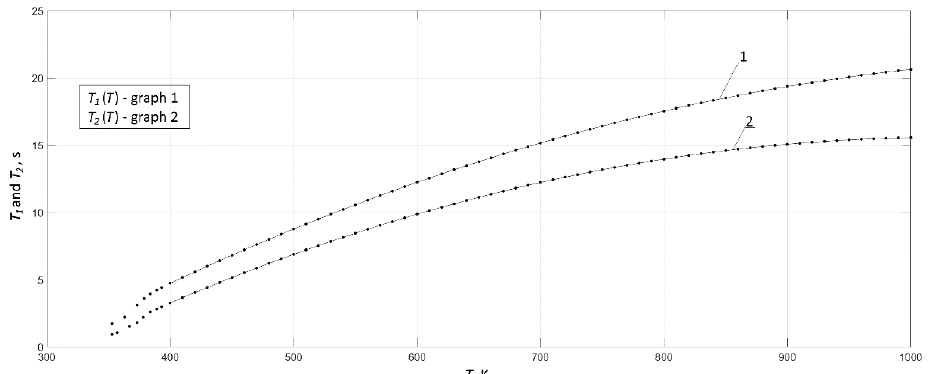
Figure 2. Extrapolation of the change in the values of the longitudinal T 1 and transverse T 2 relaxation times from the temperature T of an aqueous solution (H 2 O + H 3 CO 3 ) with plutonium nitride filling. Graph 1 corresponds to the change in the value of T 1 , graph 2- T 2 .